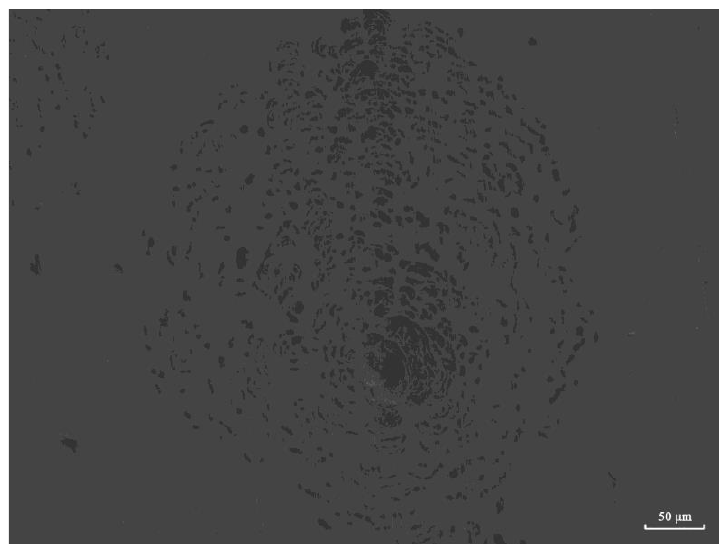
Figure 15. SEM image of pitting corrosion.